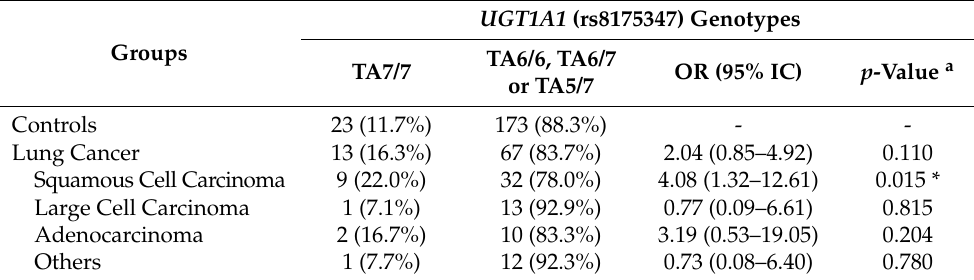
Table 3. Risk for lung cancer and its histological types, associated with the UGT1A1 gene polymor- phism genotypes.